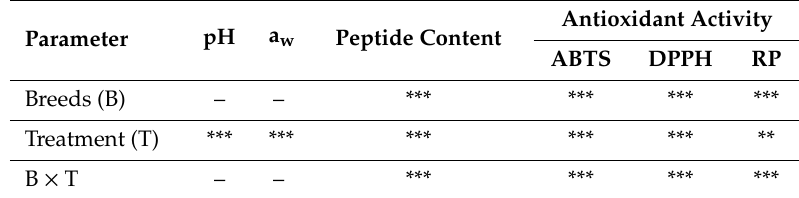
Table 2. Significance levels showed by experimental factors and their interactions for analyzed parameters of lamb raw meat and products. Parameter pH a w Peptide Content